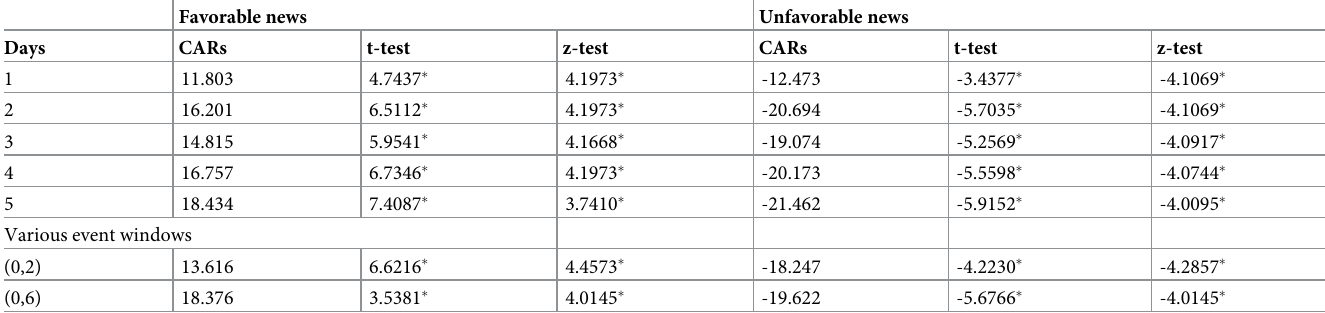
Table 5. Post-event CARs for the first sub-period (1.01.2011–31.12.2013)–favorable and unfavorable events.